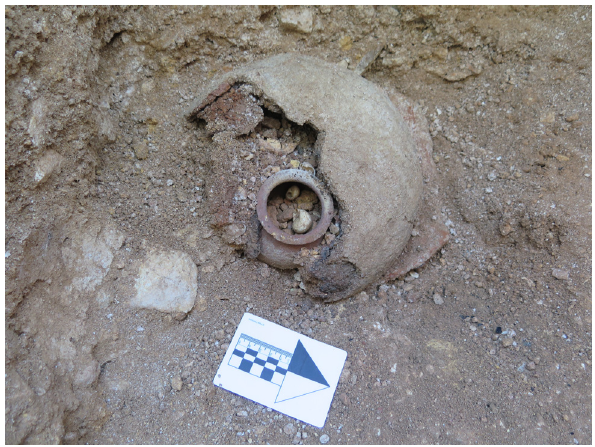
Figure 10: Partially opened cooking pots ( Sp. Finds 4 and 6 ) , uncovering contents of infant burial 3 and Special Find